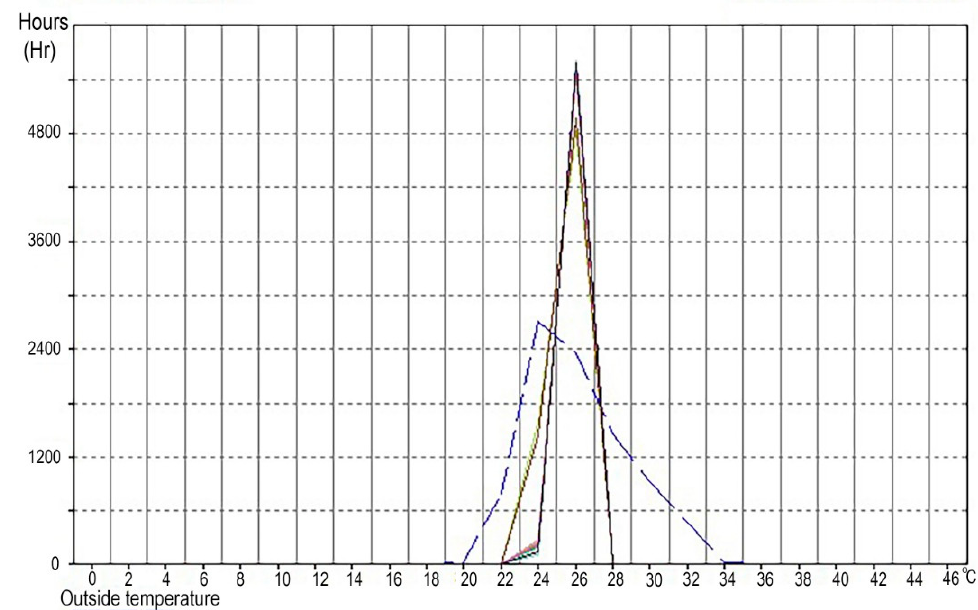
Figure 12. The outside temperature reaches as low as 20 °C and as high as 34 °C. * The 2-lines within the outside temperature band represent the temperature band (2 zones) within the building. It is largely between 24–28 °C implying that the outside temperature has been moderated from 20–34 °C to 24–28 °C as a result of the buildings’ thermal mass.